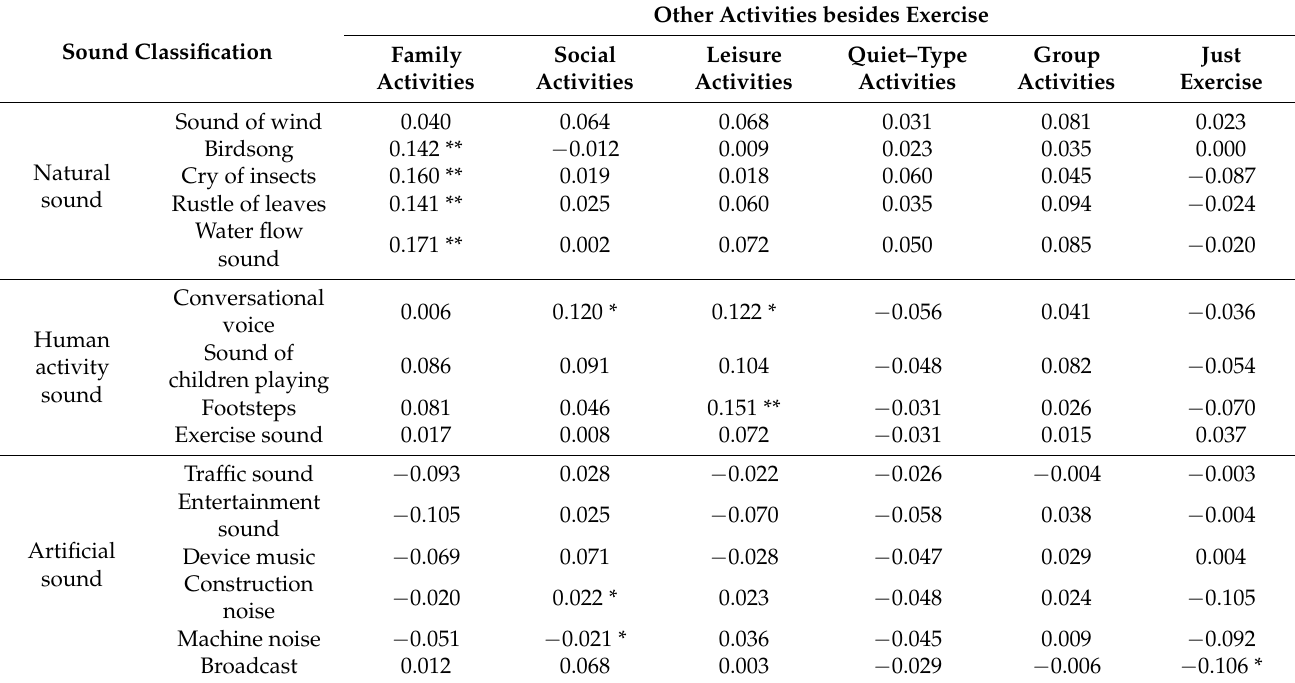
Table 7. Correlation between the choices of other types of activities other than exercise and sound- scape